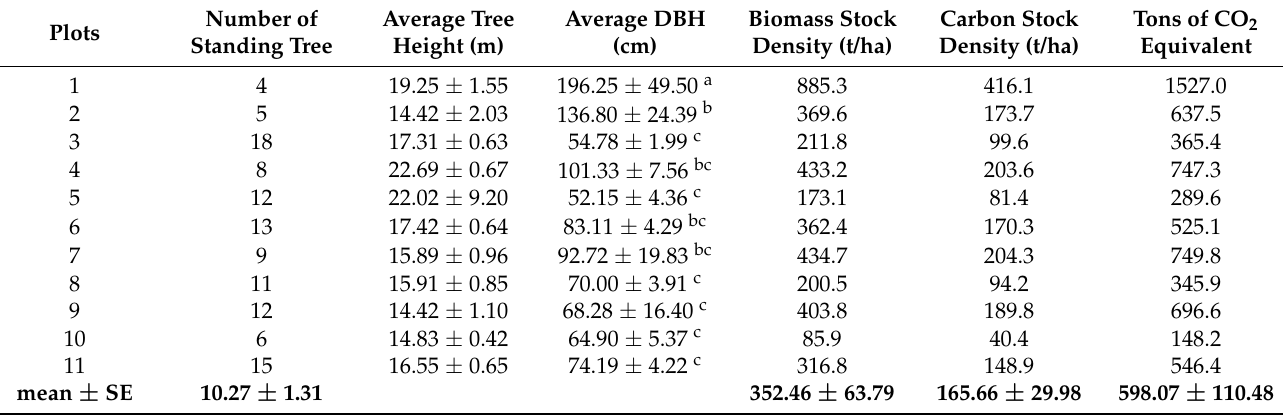
Table 1. Biomass and carbon in individual plot; data are represented as means ±